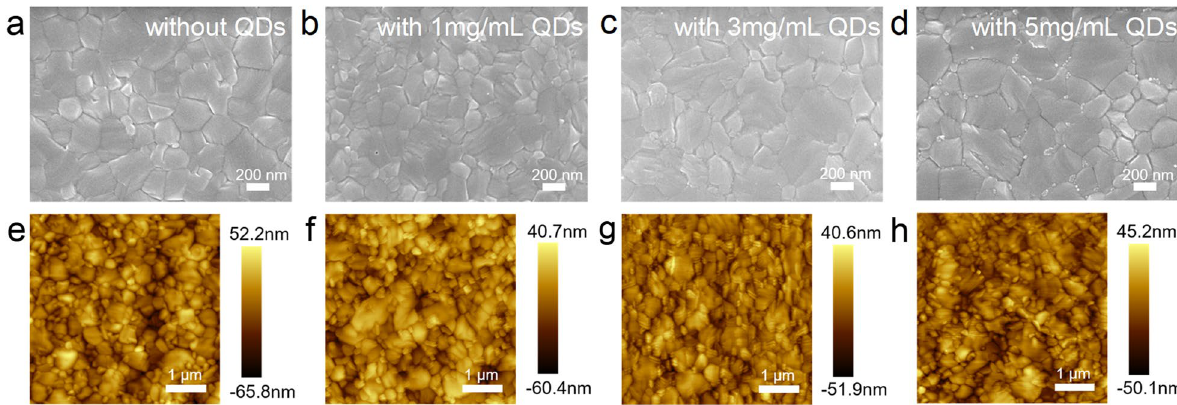
Fig. 3 a-d SEM images and e–h AFM images of control perovskite films, 1 mg/mL, 3 mg/mL and 5 mg/mL QDs passivated perovskite films,